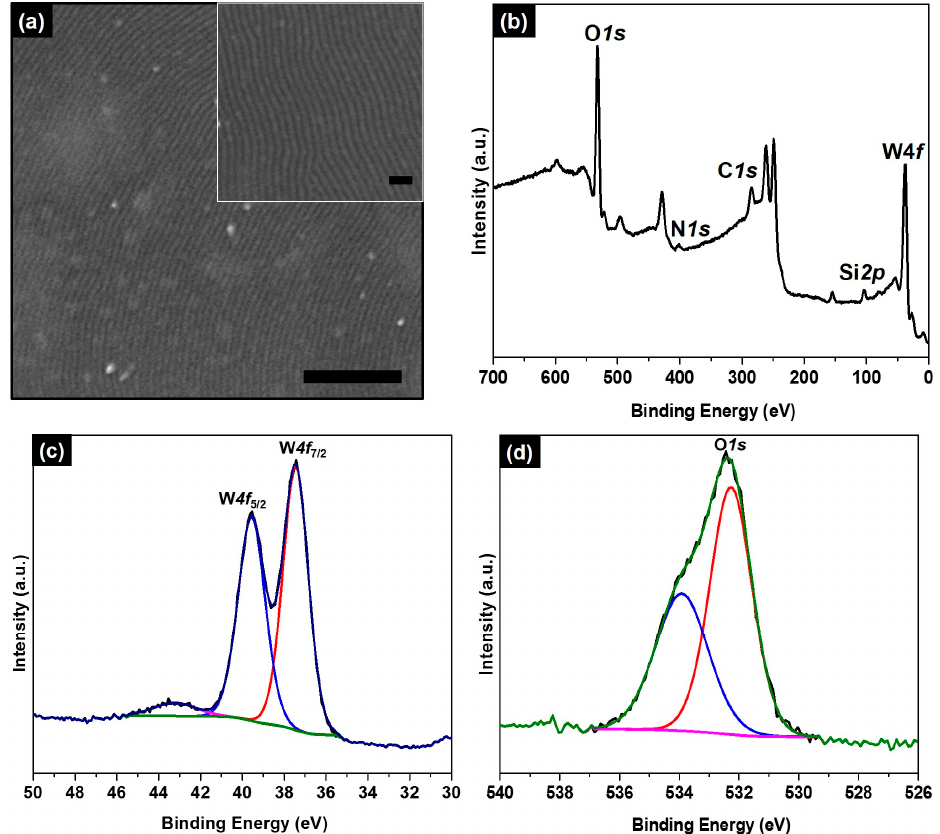
Figure 1. ( a ) SEM image of tungsten trioxide nanowires from PS-b-P4VP line template and tungsten chloride ethanolic precursor post UV/O 3. Scale bars correspond to 500 nm (main image) and 100 nm (inset), respectively. Corresponding XPS analysis of nanowires showing ( b ) survey spectrum, ( c ) W 4f high-resolution core scan, and ( d ) O 1s high-resolution core scan.